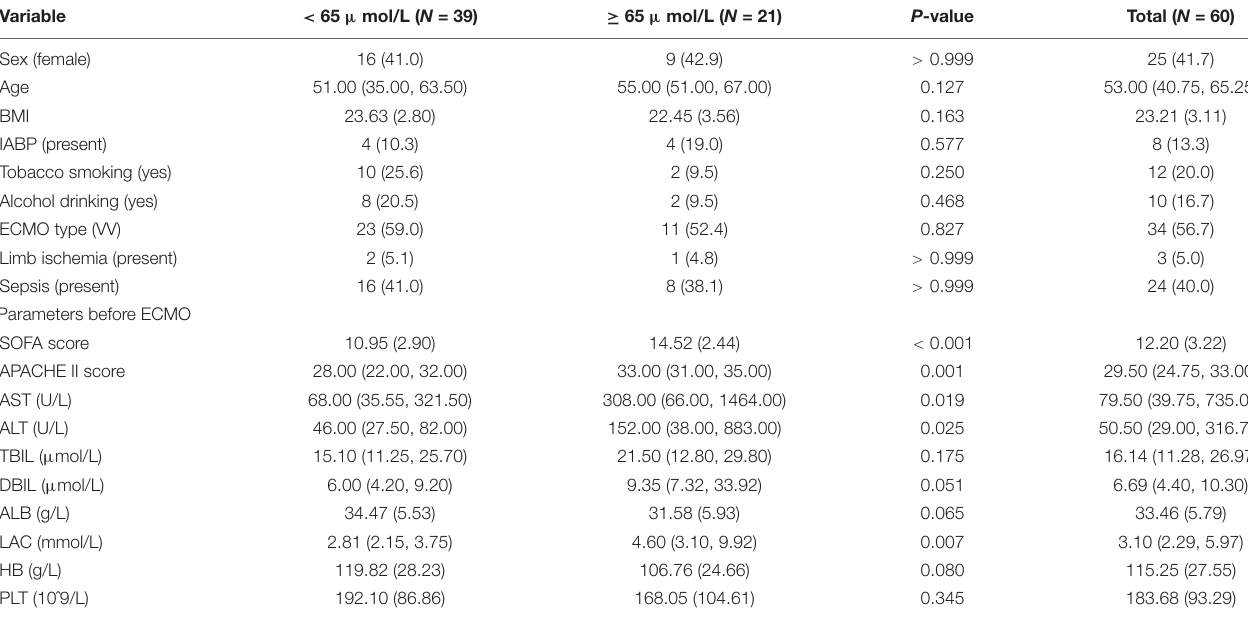
TABLE 2 | Comparison of the characteristics between the patients with high and low TBIL during ECMO.